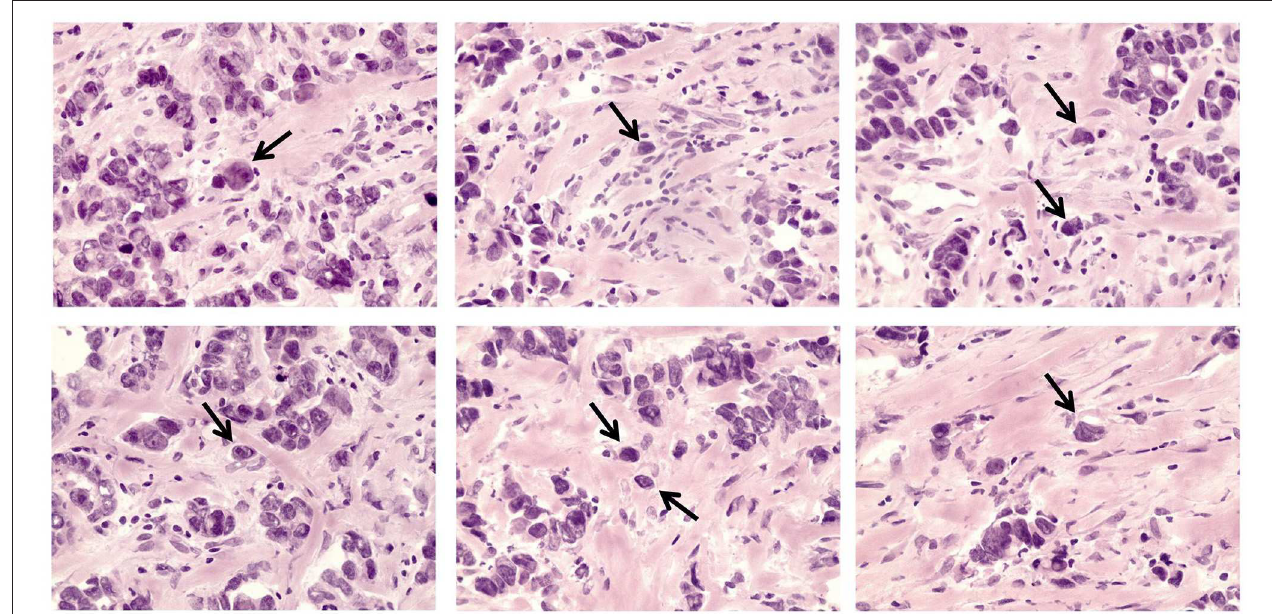
FIGURE 1 | eSTCs in invasive breast carcinoma of no special type. Arrows indicate eSTCs located out of multicellular structures. 400 × magnification.